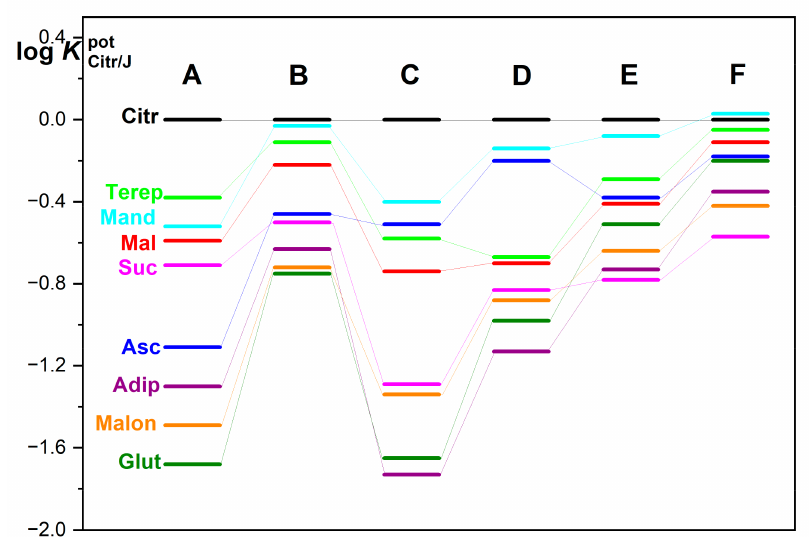
Figure 8. Graphic representation of the potentiometric selectivity coefficients (log K pot. tilayer polymer electrodes labeled: PNR (A); PTh-PNR (B); PTh-PANI-PNR (C), PTh-PNR-PANI (D); PTh-PPy-PNR (E) and PTh-PNR-PPy (F), where the abbreviations of individual carboxylates are: Adip = adipate; Asc = ascorbate; Citr = citrate; Glut = glutarate; Mal = malate; Suc = succinate; Malon = malonate; Mand = mandelate; Terep =